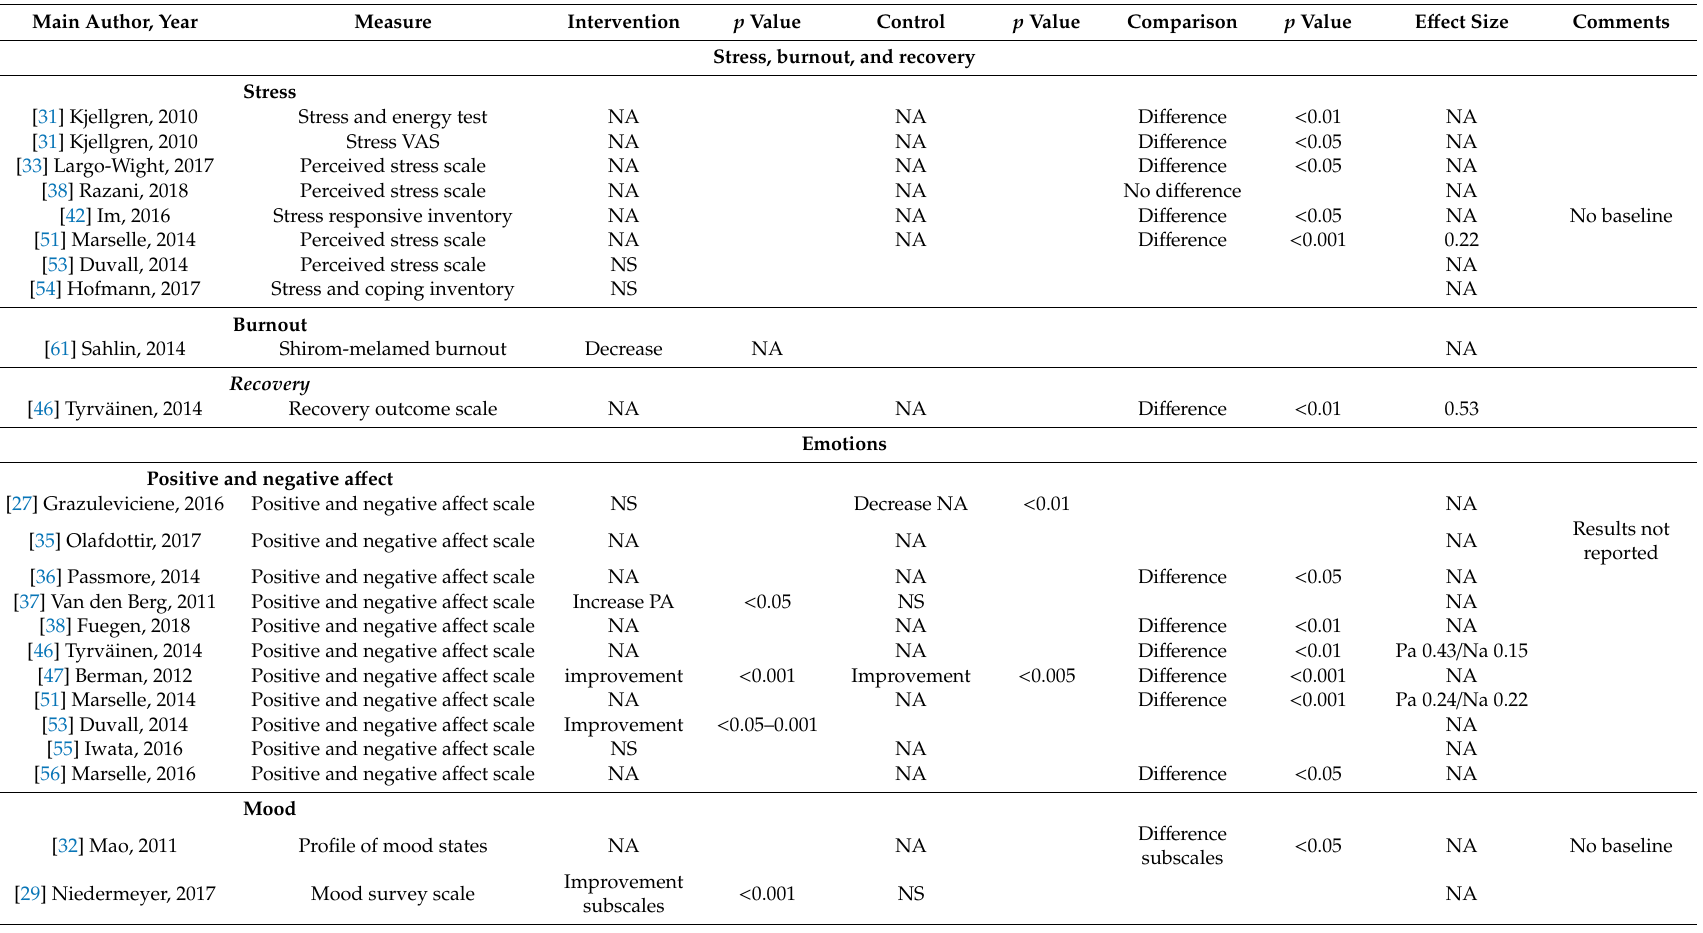
Table 3. Overview of psychological measures and